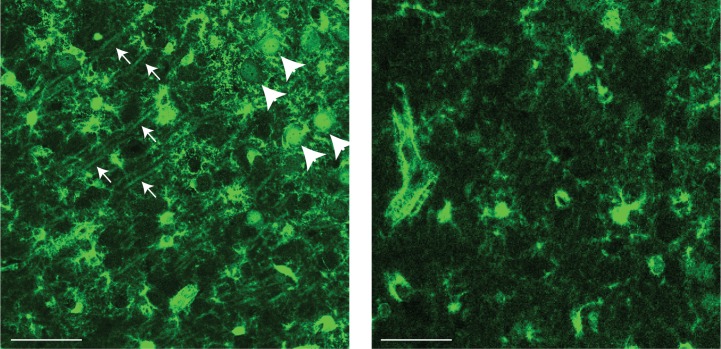
S100 protein is present in subiculum pyramidal cell bodies and primary dendrites in the proximal subiculum.Left: Expansion of S100 protein labeled via immunohistochemistry in the spatial domain of cluster 1. In addition to astrocyte labeling (as expected from astrocyte-marking nature of S100), pyramidal cell bodies and primary dendrites are also apparent (examples denoted by large and small arrows, respectively). Right: As in left, but for a region of subiculum distal to the spatial domain of cluster 1. Note the general decrement in fluorescence, as well as lack of neuronal cell bodies and primary dendrites. Scale bars: 50 μm.